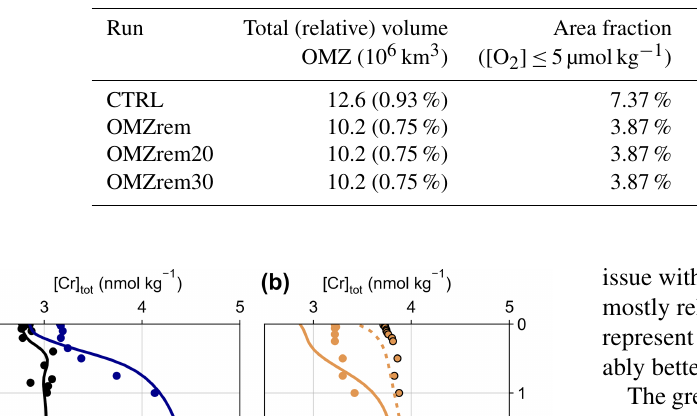
Table 3. OMZ volumes and sediment area below OMZs, as well as fraction of total Cr burial flux below OMZs. See Table 2 for more specific information on the experiments.